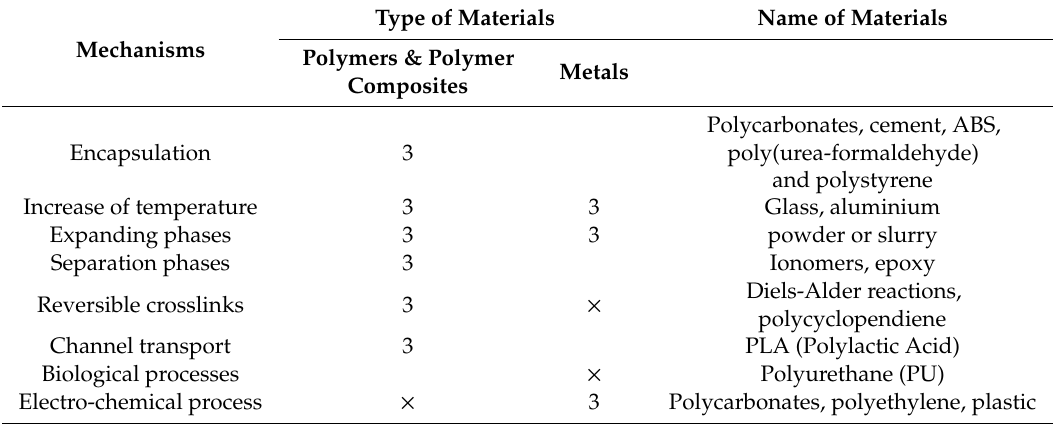
Table 1. Healing mechanism for di ff erent materials; the symbol indicates the expected or demonstrated level of success (tick for applicable and cross for not